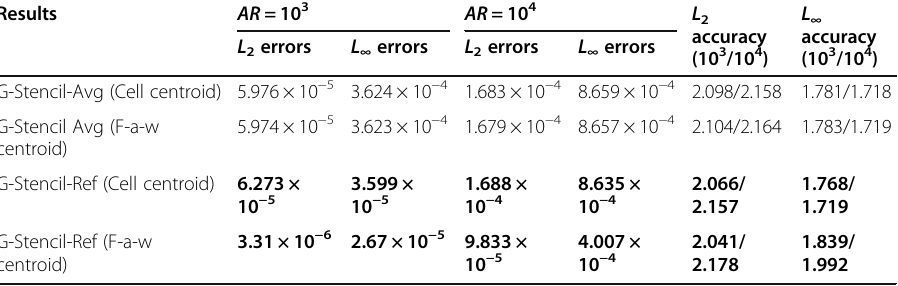
Table 4 Computational errors on the finest grid and L 2 , L ∞ accuracy between the last two grids of different stencils on the second- and third-order unstructured finite volume solver